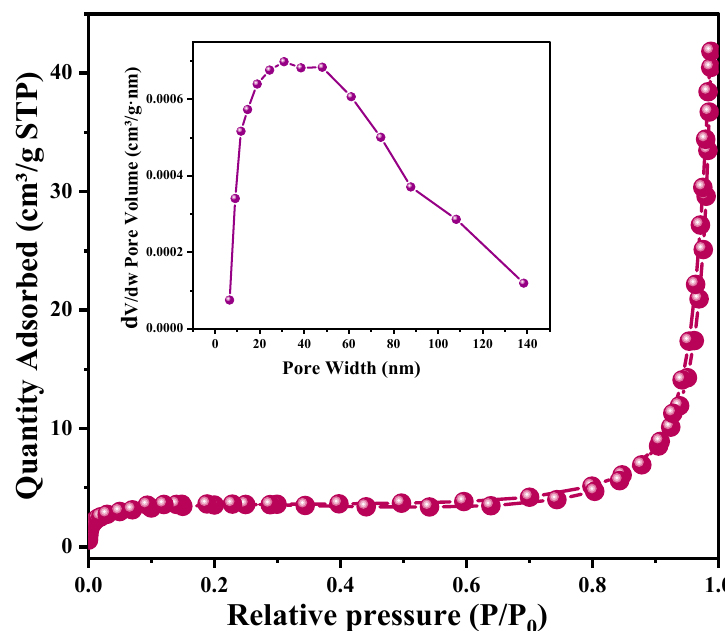
Figure 7. N 2 adsorption/desorption isotherm of 0.5PBB